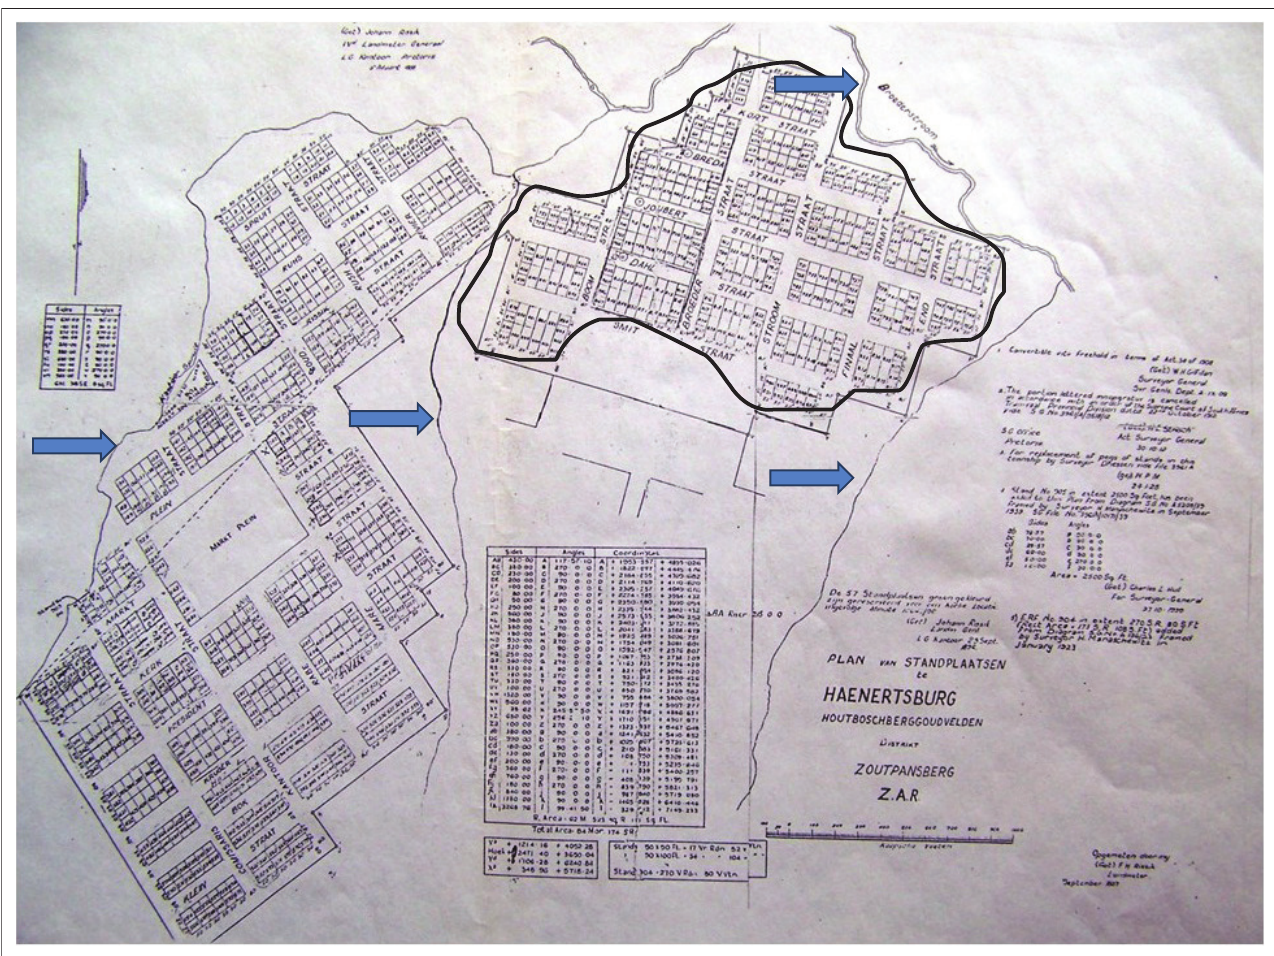
FIGURE 4: The original town plan of Haenertsburg, Limpopo Province, South Africa, as surveyed in 1887. The arrows indicate water drainage lines. The solid line indicates an undeveloped area with important medicinal plants that has been excluded by provincial government from the proposed nature